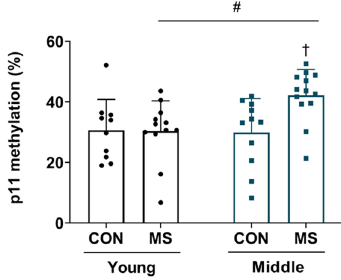
Figure 4. Alterations in DNA methylation at the hippocampal p11 promoter in young adult and middle-aged mice following MS exposure. DNA methylation levels at the hippocampal p11 promoter were measured using methylation-specific polymerase chain reaction (MSP). All analyses were performed on the hippocampus. Ct values were normalized to GAPDH. Data are expressed as percentage of methylated DNA described in “Methods” and are represented as mean ± SEM ( n = 10–12/group, young adulthood; n = 11–13/group, middle adulthood). † p < 0.05 vs. control in middle adulthood; # p < 0.05 vs. MS in young